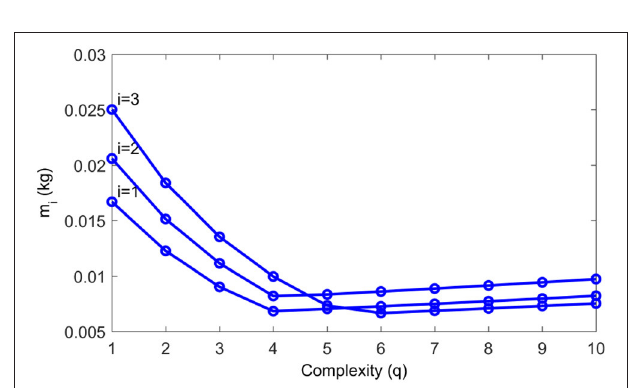
FIGURE 15 | Mass of i th D-Bar changing with complexity.